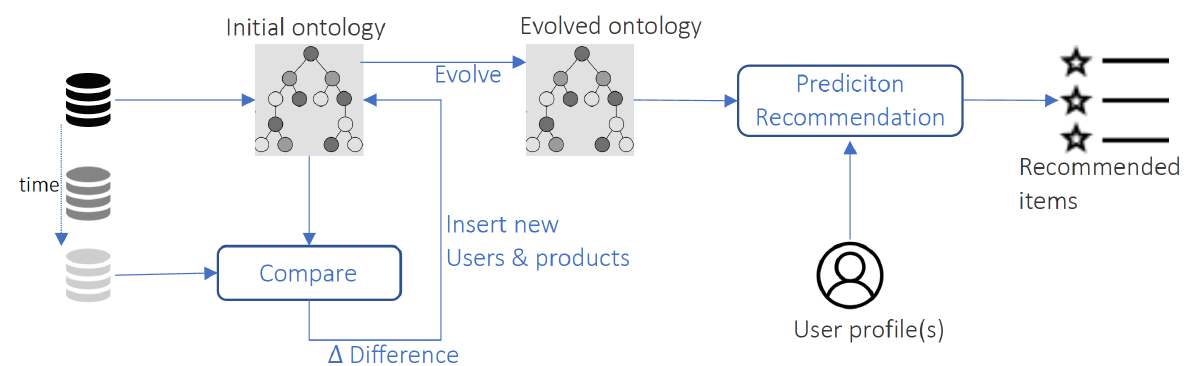
Figure 2. Overview of the